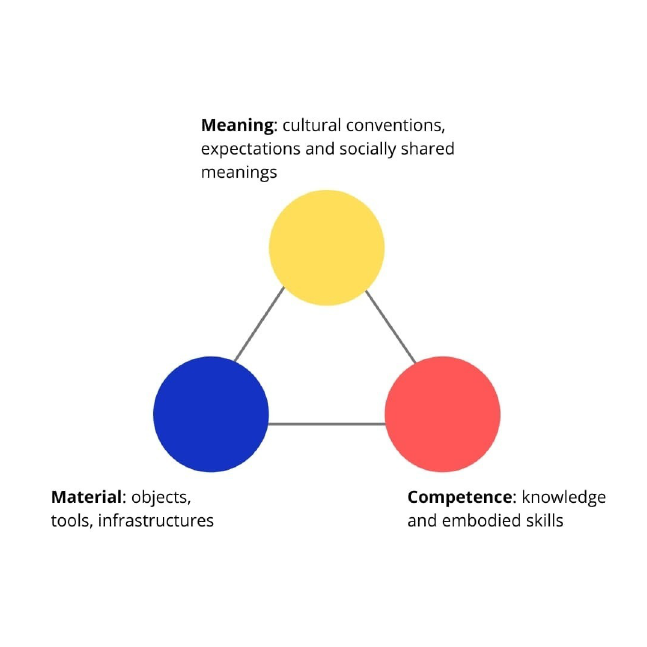
Fig. 1. Element of Practice (Shove et al ,